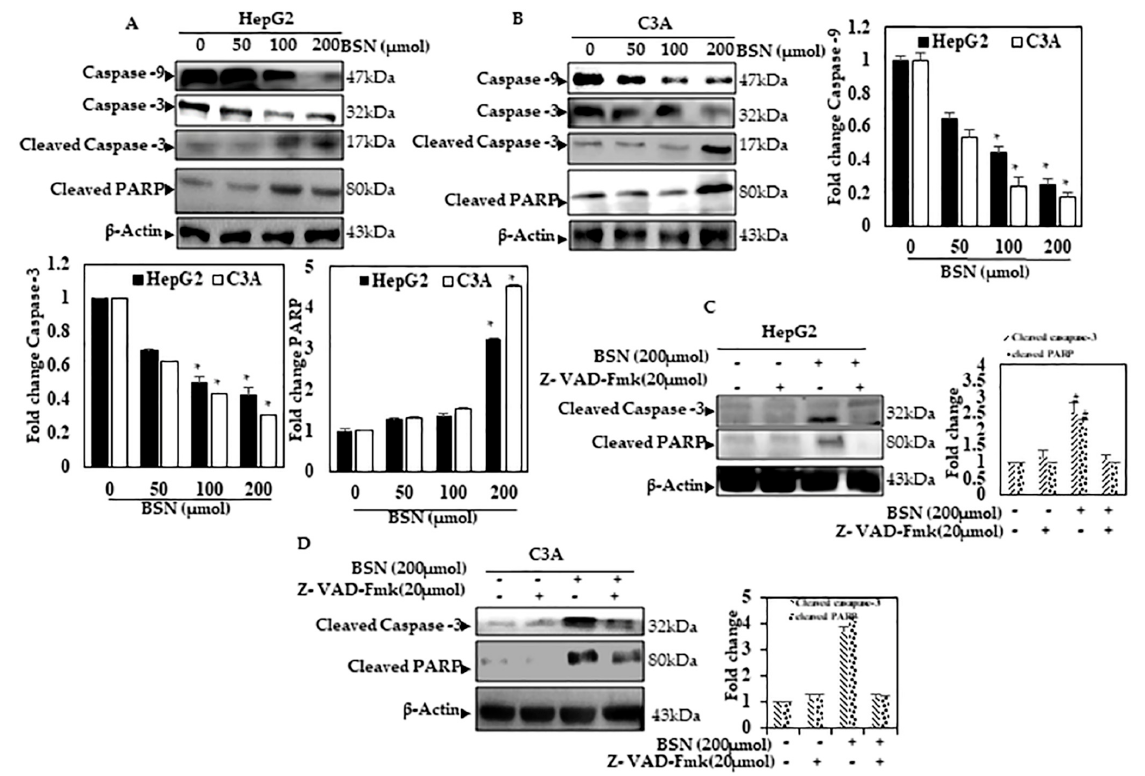
Figure 1. Caspase activation was mediated by BSN. The effect of BSN-mediated caspase cascade activation on HepG2 and C3A cells was investigated by Western blotting. ( A , B ) HepG2 and C3A cells treated with BSN (0–200 µ mol) for 48 h, and cell lysates were used for SDS-PAGE and Western blotting to analyze caspase9, caspase3, cleaved caspase-3, and cleaved PARP. β -actin was used as an internal control. The effect of Z-VAD-FMK on BSN induced apoptosis. The pre-treatment of cells